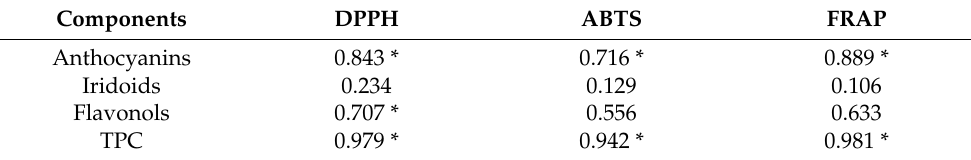
Table 2. Correlation coefficients between antioxidant capacity and bioactive compounds. Components DPPH ABTS FRAP Anthocyanins 0.843 * 0.716 * 0.889 * Iridoids 0.234 0.129 0.106 Flavonols 0.707